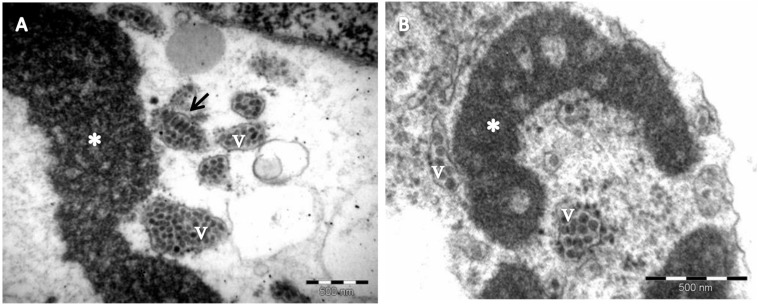
Electron micrograph of passion fruit green spot virus (PfGSV)-infected passion fruit leaves. (A,B) Micrographs of thin sections of tissues from green patches on senescent passion fruit leaves, collected in commercial fields near Sinop, State of Mato Grosso, Brazil. Large, electron-dense and vacuolated inclusions (viroplasms) (∗) are present in the cytoplasm of parenchymal cells. Short, bacilliform particles, presumed PfGSV virions, can be seen accumulating within cisternae of the endoplasmic reticulum, either in cross- (v) or longitudinal (arrow) sections.